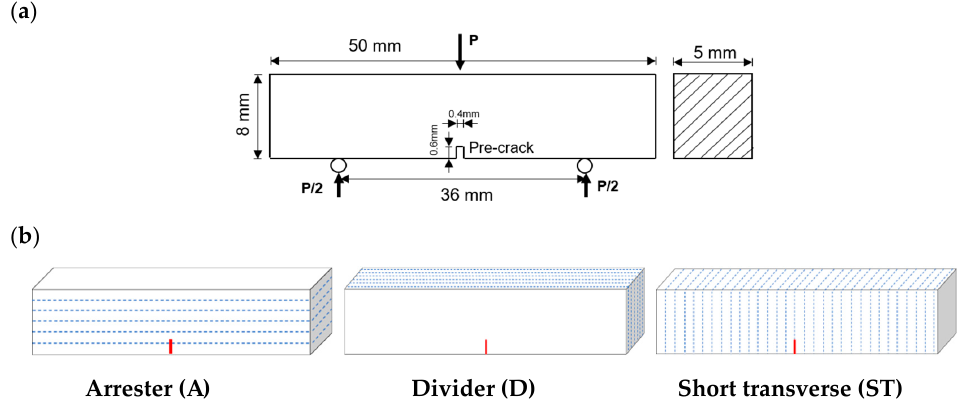
Figure 2. Preparation of the shale beam specimens for the three-point bending experiments: ( a ) Schematic diagram of the three-point bending specimens and ( b ) the three crack orientations relative to the bedding planes.